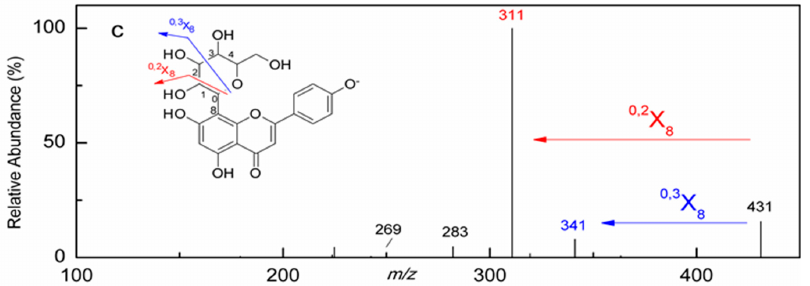
Figure 3. The MS/MS spectra and proposed fragmentation pathways of representative C -glycosides of isoorientin ( a ) (Peak 2 ), orientin ( b ) (Peak 1 ) and vitexin ( c ) (Peak 3 ). The peak numbers in this figure correspond to those used in Table 1.